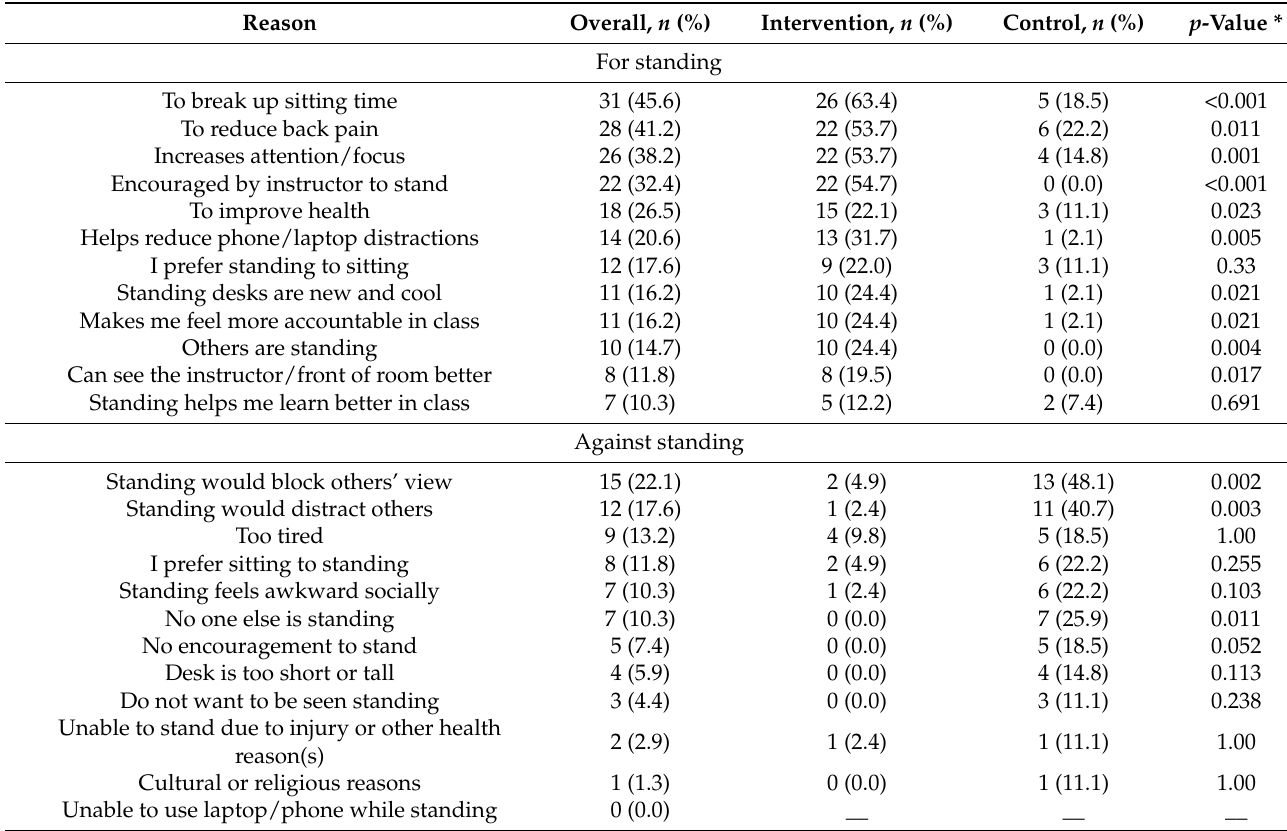
Table 3. College students’ most frequently reported reasons for and against standing from most to least frequent, including the differences between the intervention and control